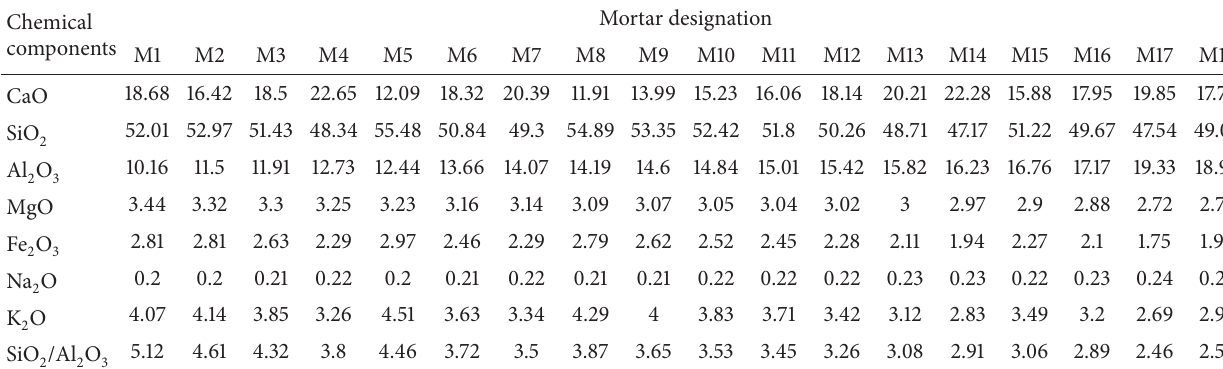
Table 6: The major chemical components of mortar.